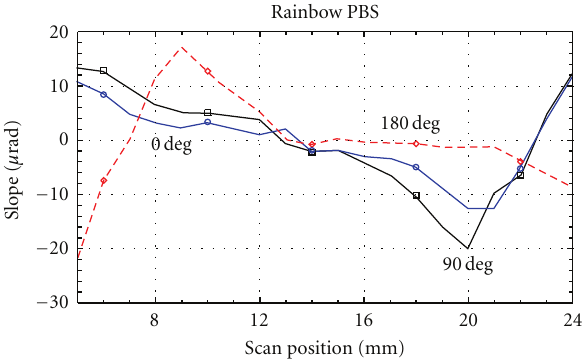
Figure 5: Results of slope measurement of the PBS produced by Rainbow Research Optics Inc., USA, tested at 0 ◦ , 90 ◦ , and 180 ◦